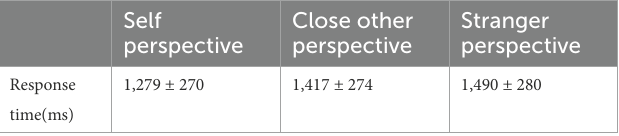
TABLE 1 Descriptive statistics for the response time of dilemma stage ( M ± SD). Self